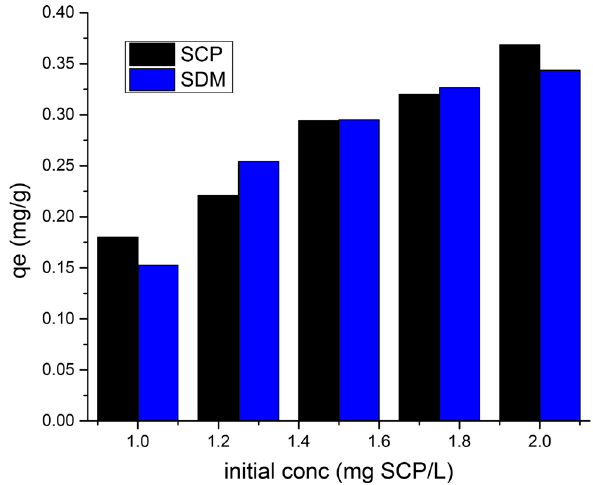
Fig. 6 Effect of initial concentration for adsorption of SCP and SDM onto Fe-MC ( m = 0.1 g/50 mL, pH = 6.4, 303 K)